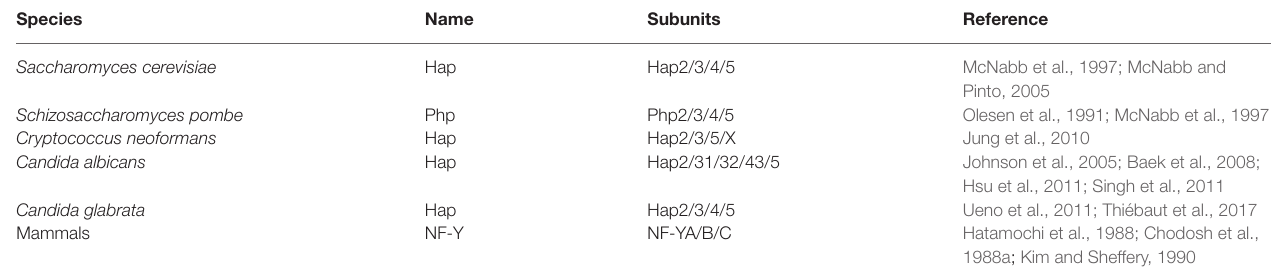
TABLE 1 | CCAAT-box binding proteins in this